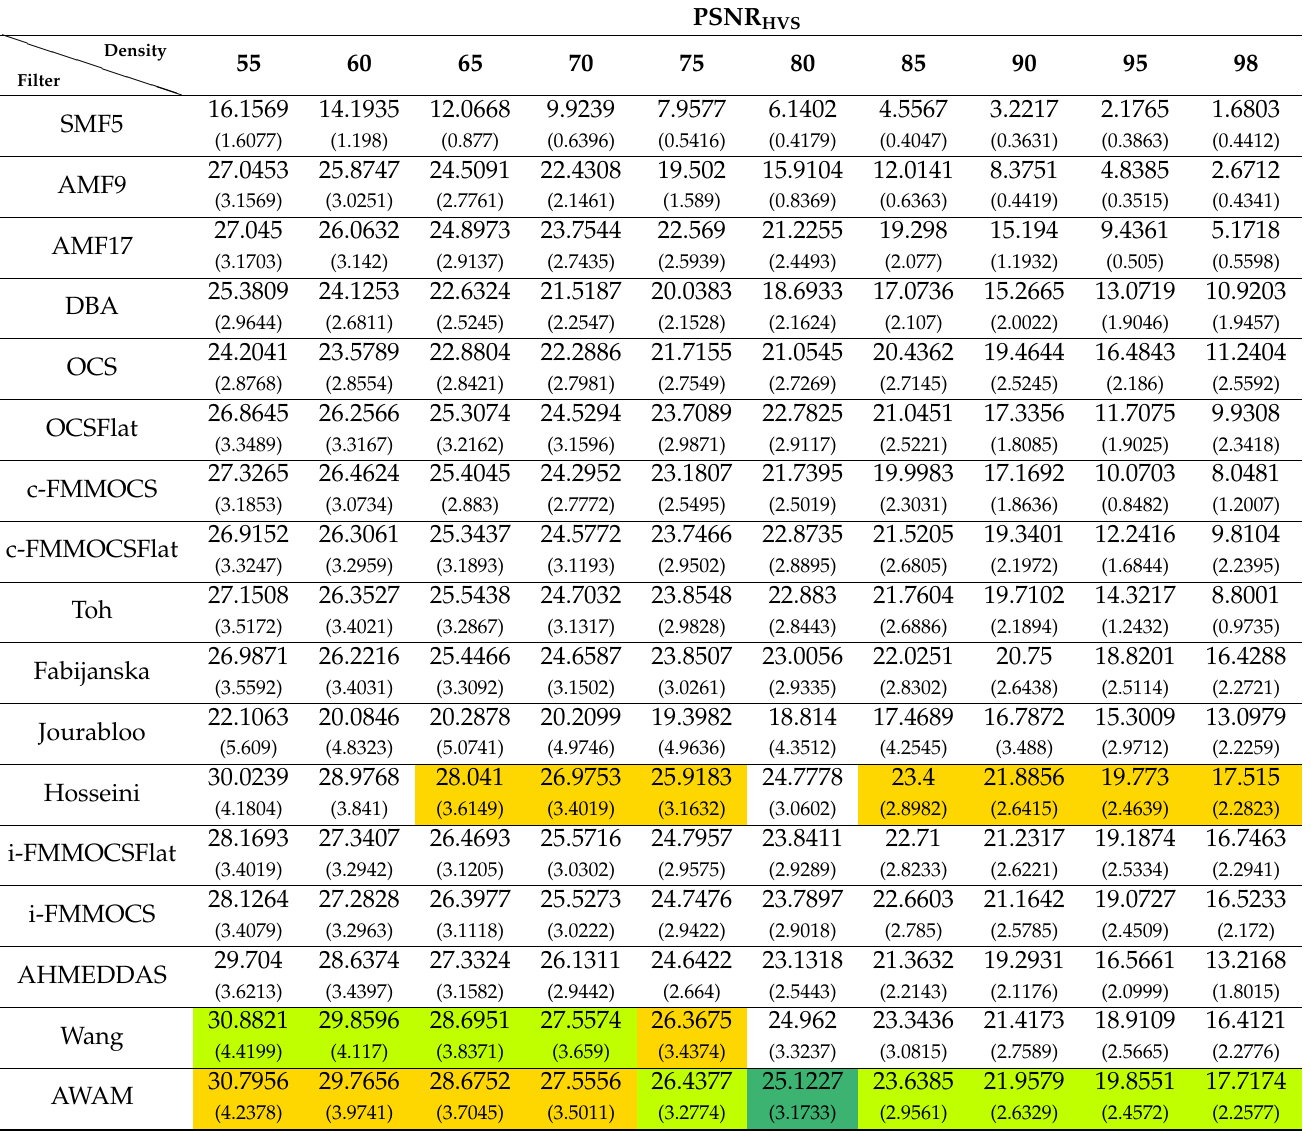
Table 4. PSNR HVS average values and standard deviations of the studied algorithms for the sequence of densities of noise from 55% to 95% with a step of 5% and